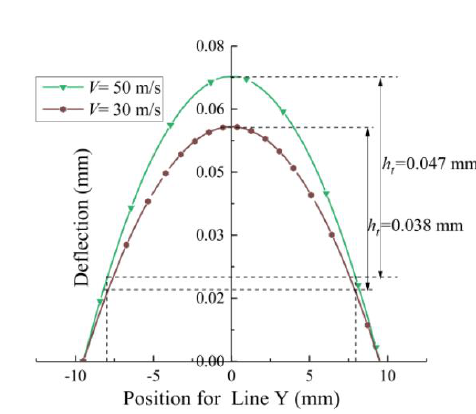
Figure 14. Total deflection. ( a ) Along the length profile and ( b ) across the width profile. (3) Almen Intensity